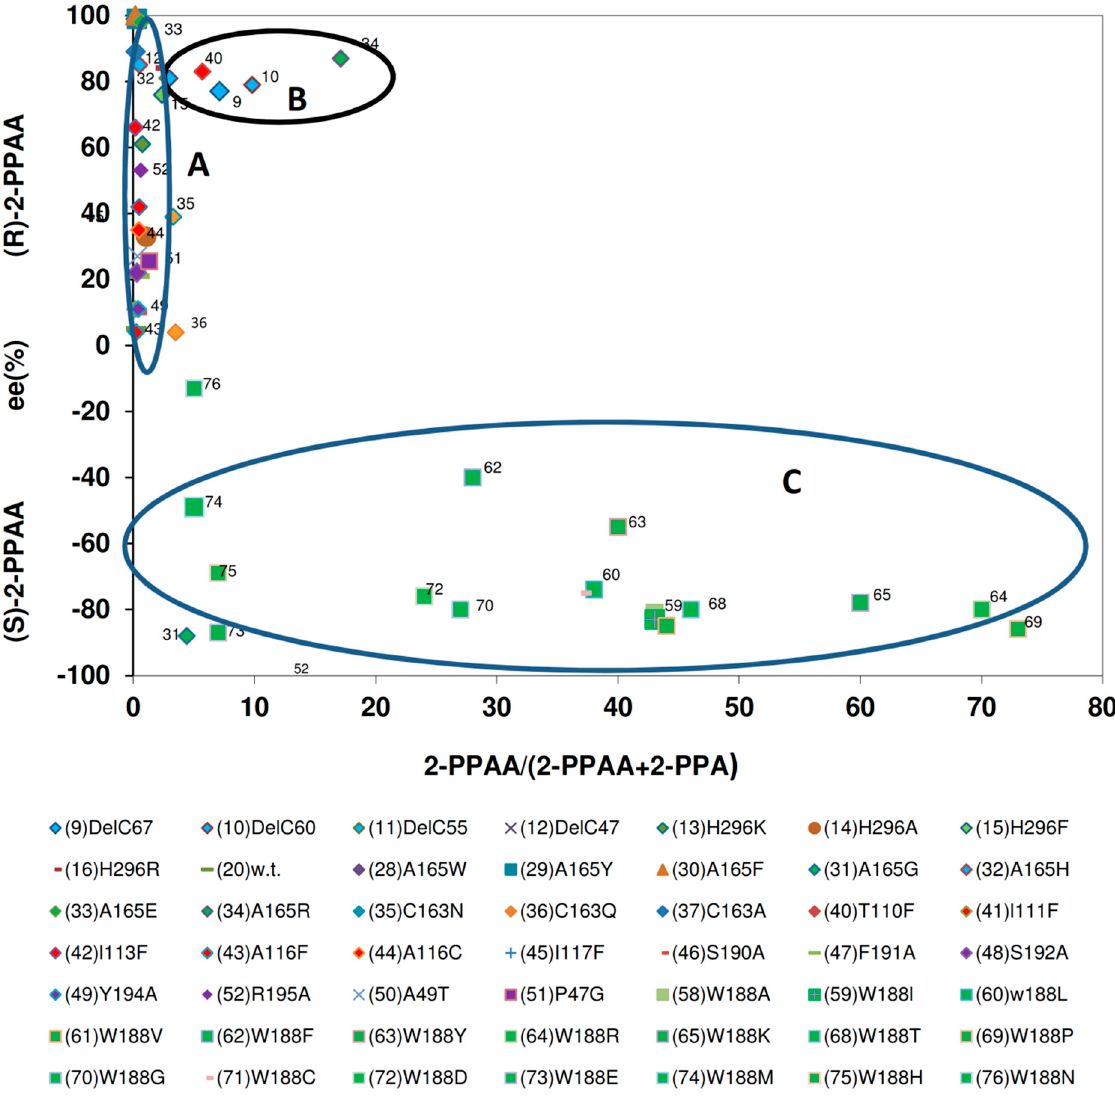
Figure 9. Relationship between the amounts of 2-phenylpropionamide formed from ( R , S )-2-phenylpropionitrile and the enantiomeric composition of the amide. The data were taken from previous publications (see Figure 6).